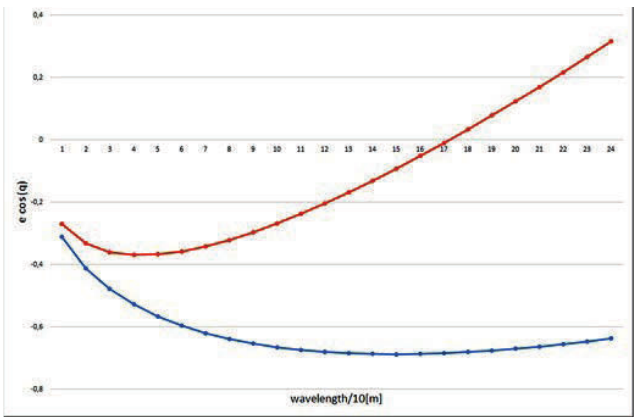
Fig. 2. The dependence of the resonant zone width on the wave length λ.